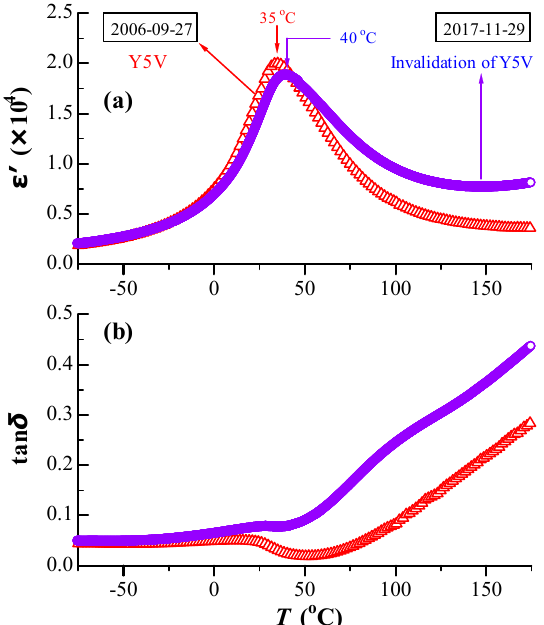
Figure 2. Temperature dependences of ( a ) ε ′ and ( b ) tan δ for BN4TC5, measured in 2006 and again in 2017.